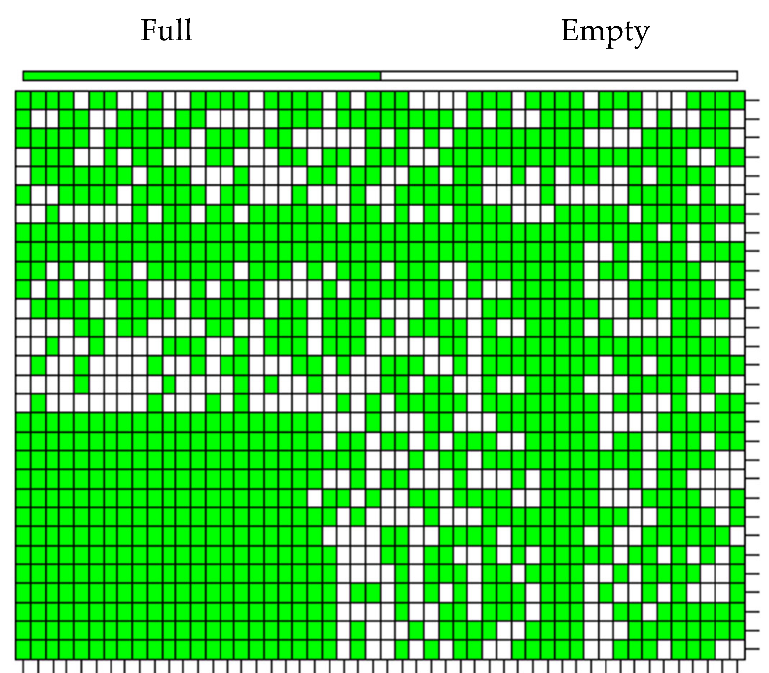
Figure 9. Final storage locations after considering storage reallocation. Table 4. Final results after considering storage reallocation.